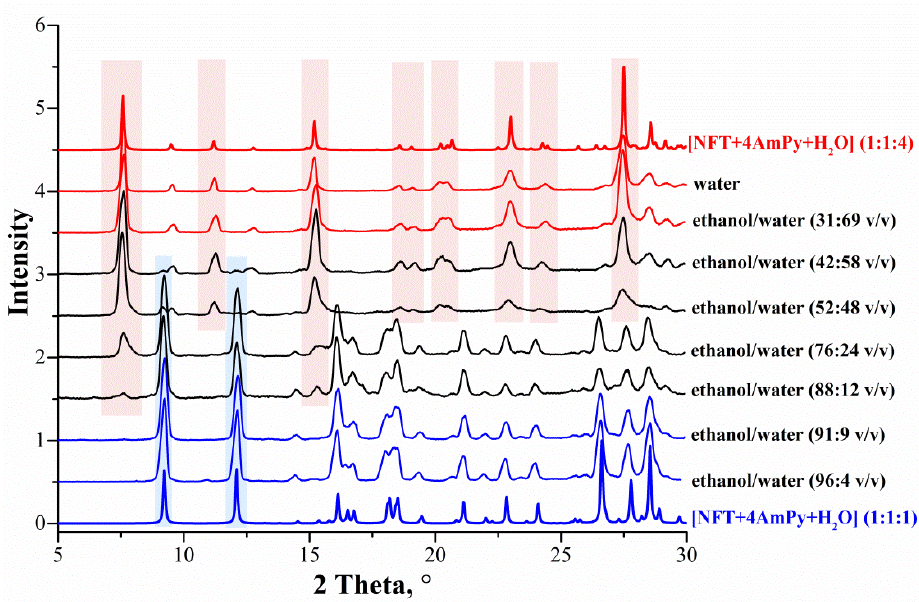
Figure 4. Comparison of the experimental PXRD patterns of the powdered samples prepared by grinding the NFT and 4AmPy physical mixture in the presence of ethanol/water mixtures of various compositions with the simulated PXRD patterns calculated from SCXRD data.